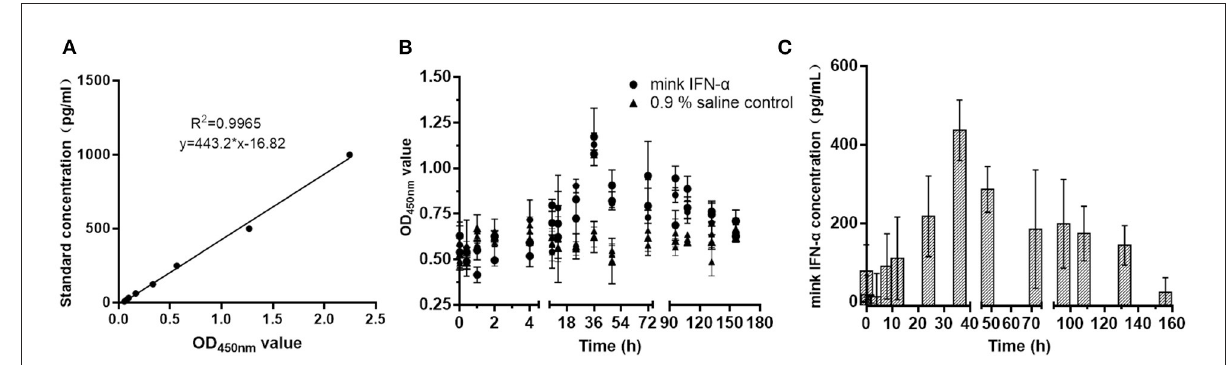
FIGURE7 Detection of the metabolism of MiIFN- α in rats. (A) Standard curve drawing of canine IFN- α ELISA kit. (B) OD 450nm absorbance at different time points. (C) Residual concentration of interferon- α at different time points in rats.